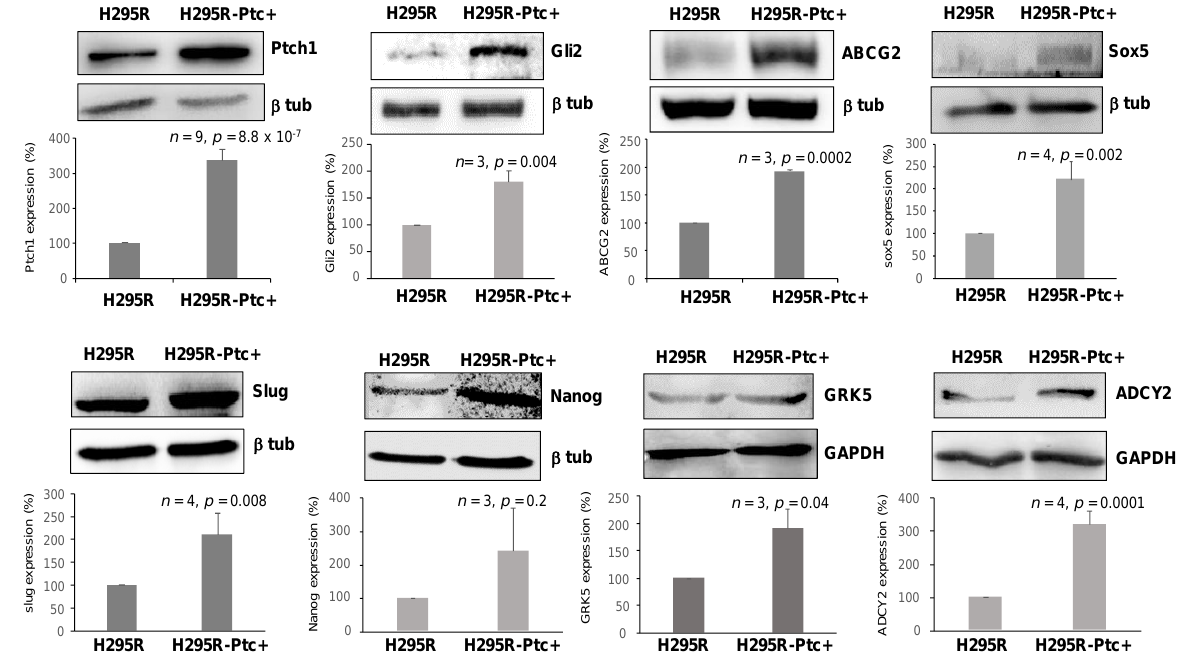
Figure 8. Protein expression of some differentially expressed genes between H295R cells parental and H295R PM-Ptc+ cells FACS sorted and amplified. Western blots were performed using anti- DEG antibodies, and β -tubulin or GAPDH antibodies for the loading control. Signals on Western blots were quantified using ImageJ software. Data presented are the mean ± SEM of at least 3 independent experiments. p -values were calculated using Student’s